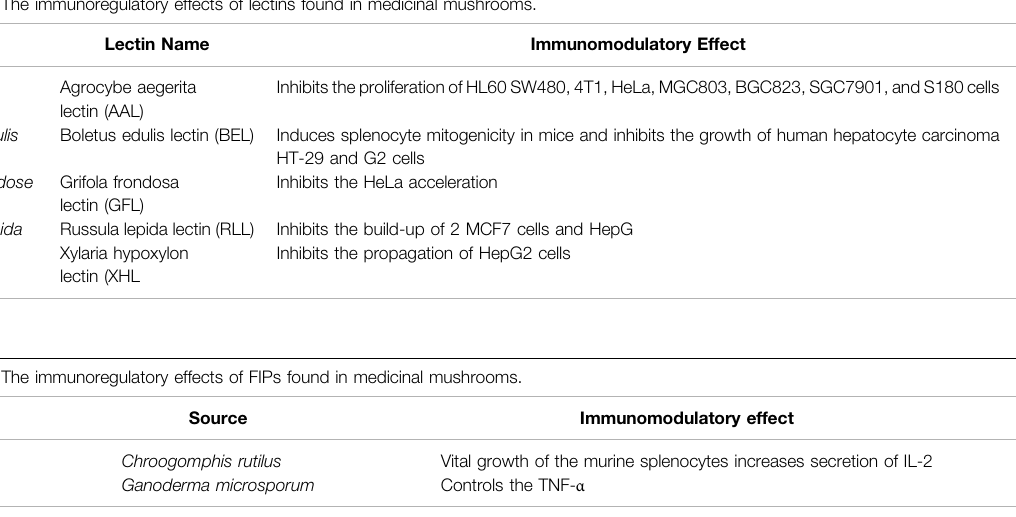
Figure 1 . All of these drugs have anticancer, et al., 2008). Their mode of action, as well as the structure-